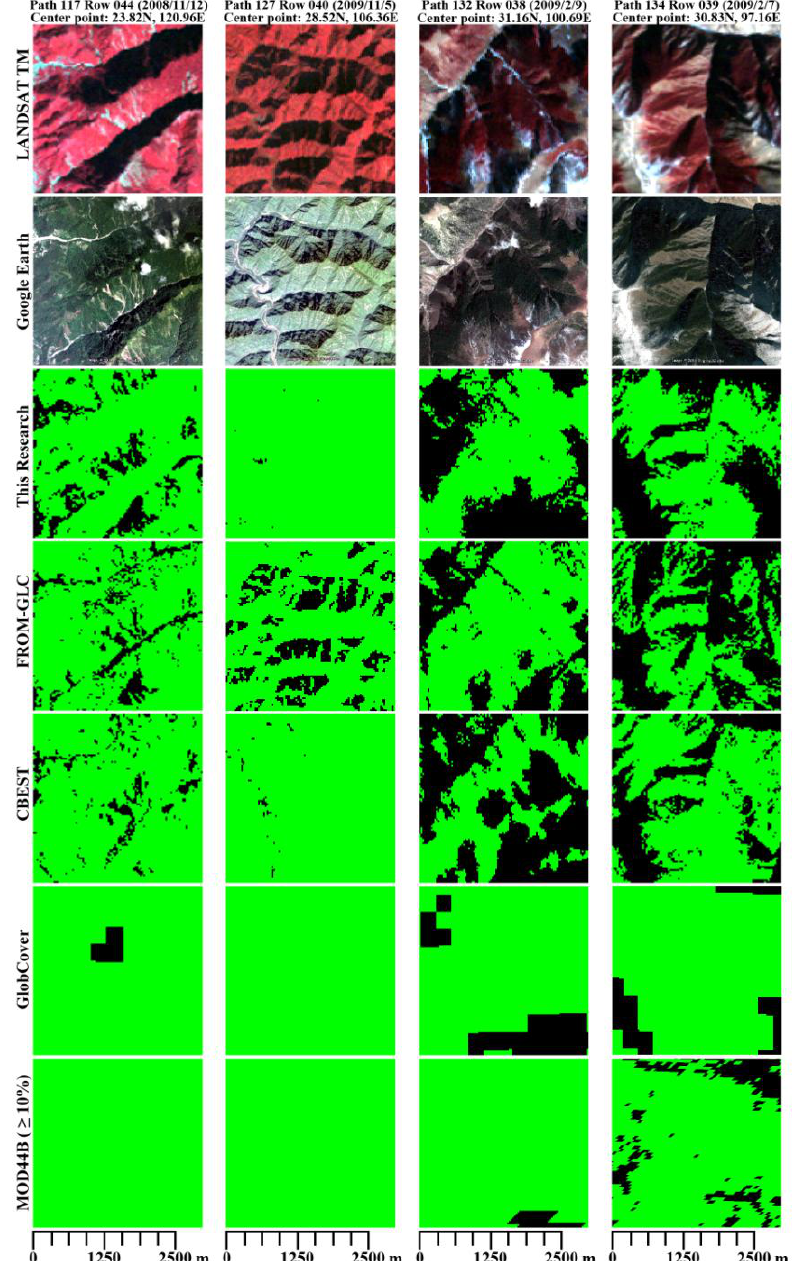
Figure 7. Selected case comparison of forest extent products with this product in mountainous areas (Green color represents forest and black represents non-forest.) From left to right, the image segments were selected from Taiwan, Sichuan Province, Sichuan Province, and